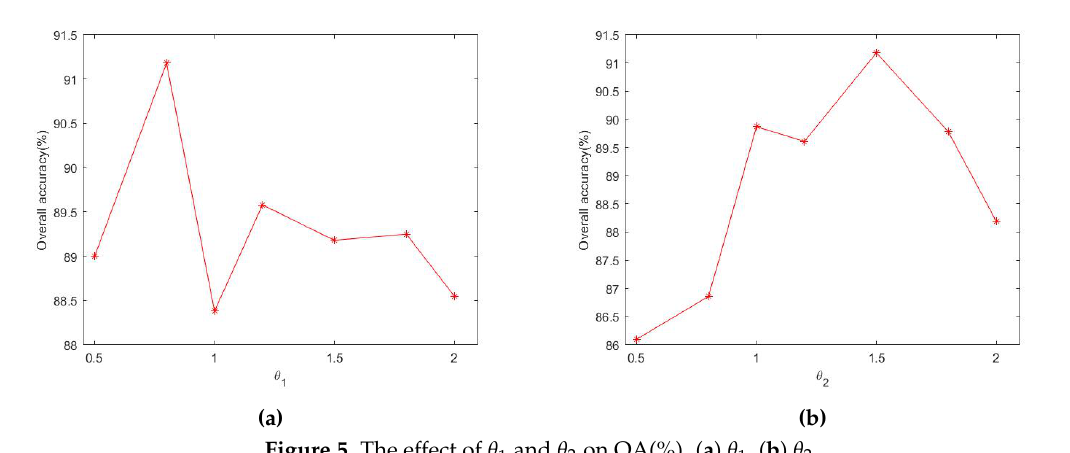
Figure 5. The effect of θ 1 and θ 2 on OA(%). ( a ) θ 1 , ( b ) θ 2